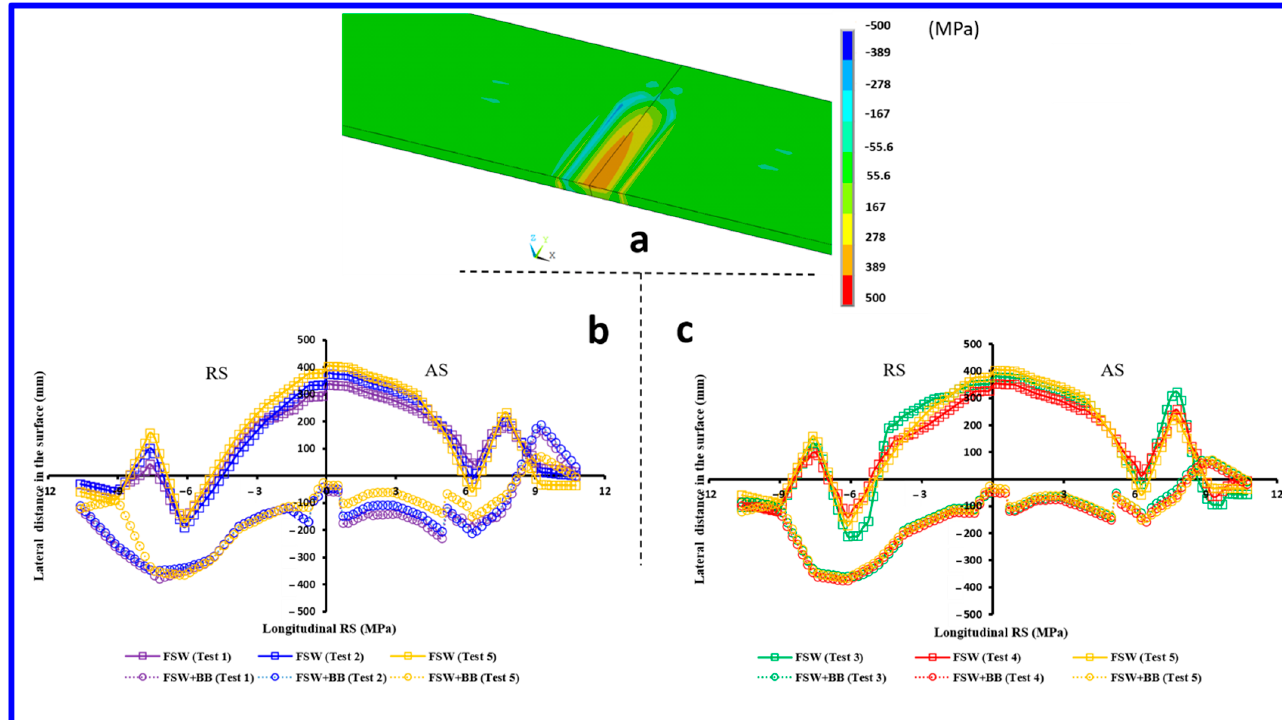
Figure 19. ( a ) LRS contour for Test 2 after FSW process. LRS changes along the transverse path at the surface in the middle of the weld line, after FSW and BB for ( b ) tests 1,2 and 5; ( c ) tests 3, 4 and 5.